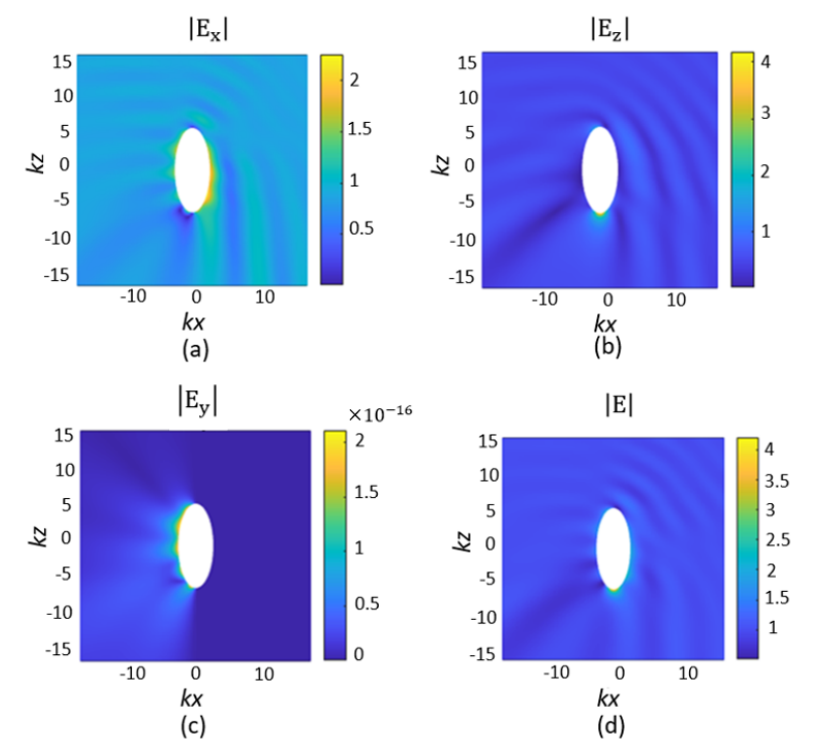
Figure 12. Field maps across the xz -plane for the case of TM polarization for the same case as in Fig- ure 2, the magnitude of the electric field components | E x | , The magnitude of the electric field | E x | is shown in ( d ).